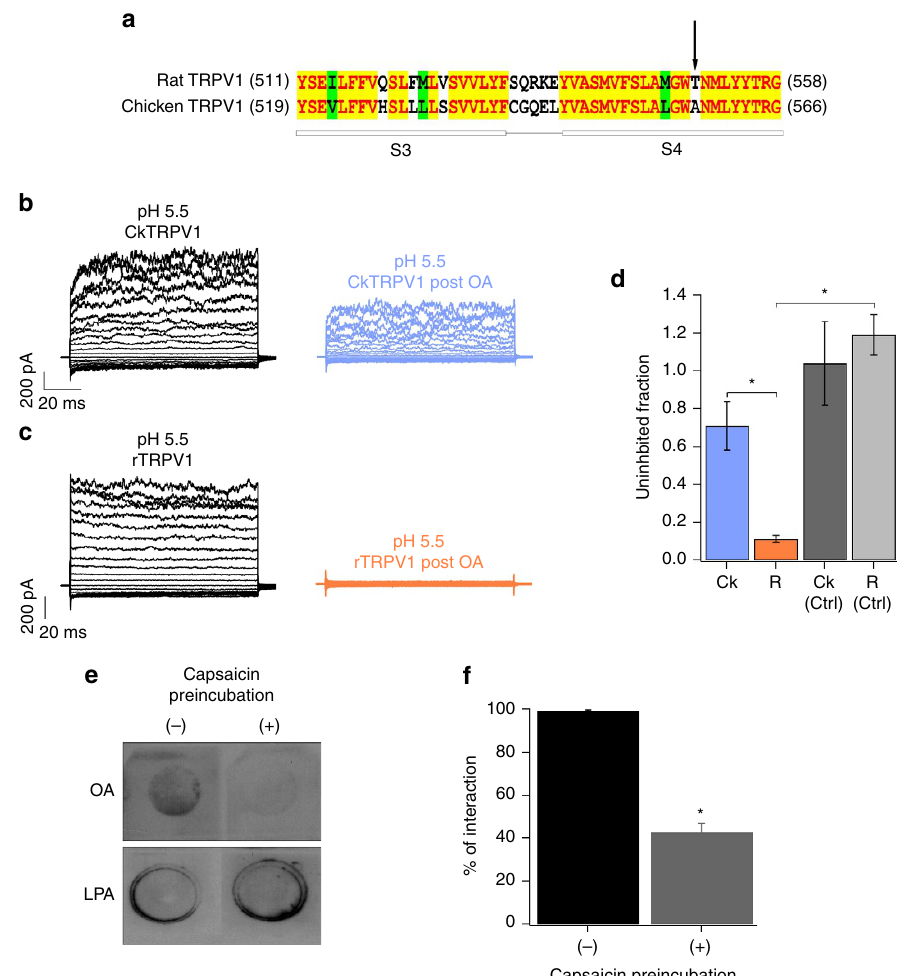
Figure 4 | Inhibition of TRPV1 from different species by oleic acid. ( a ) Sequence comparison between rat (r) and chicken (Ck) TRPV1 vanilloid-binding pockets (VBPs). Yellow denotes conserved residues. The arrow denotes residues T550 in rat and A558 in CkTRPV1. ( b , c ) Representative TRPV1 currents evoked from a pH 5.5 solution (black traces) and after 5 m M OA in an outside-out patch for CktRPV1 (blue traces) ( b ) or rTRPV1 (orange traces) ( c ) expressing HEK293 cells. ( d ) Fraction of remaining currents in CkTRPV1 (Ck) (blue bar; n ¼ 30) and rTRPV1 (R) channels (orange bar; n ¼ 30). Ck (Ctrl, n ¼ 10) and R (Ctrl, n ¼ 8) are CkTRPV1 and rTRPV1 outside-out patches exposed to vehicle (recording solution þ 0.14% ethanol (EtOH) for 5min and reactivated by pH 5.5. * P o 0.001 between groups as compared by brackets. Grey bars represent control experiments with vehicle solution for Ck and rTRPV1. ( e ) Overlay assay for LPA and OA with rTRPV1 protein preincubated in the absence ( (cid:2) ) and presence of 0.5 m mol capsaicin ( þ ). LPA (0.2 m mol) signals were not affected by capsaicin, while OA (2 m mol) signals were fainter when TRPV1 was preincubated with capsaicin (top panel). ( f ) The percentage of interaction of TRPV1 protein with OA or LPA was obtained by densitometric analysis of the spots and normalized to the positive control, which was LPA itself. For OA in the absence of capsaicin ( (cid:2) ) per cent of interaction was 99.6 ± 0.2 and in the presence of capsaicin ( þ ) per cent of interaction was 42.8 ± 4.1, n ¼ 6 for all groups. * P o 0.0001, t